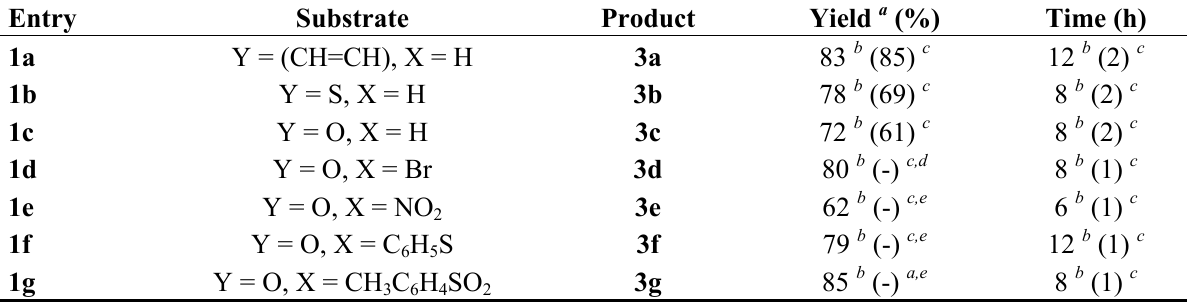
Table 1. Reaction of 3-phenyl, 3-(thiophen-2-yl) and 3-(5-substituted furan-2-yl)-2- cyanopropenenitriles 1a – g with 2-phenylbenzimidazoline ( 2 , PBI) generated in situ and with NaBH 4